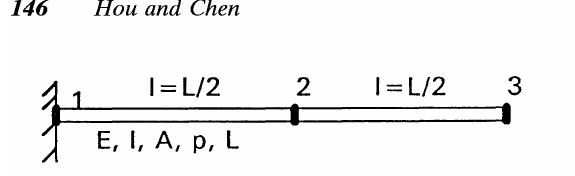
FIGURE 1 A simple finite element model for a canti lever